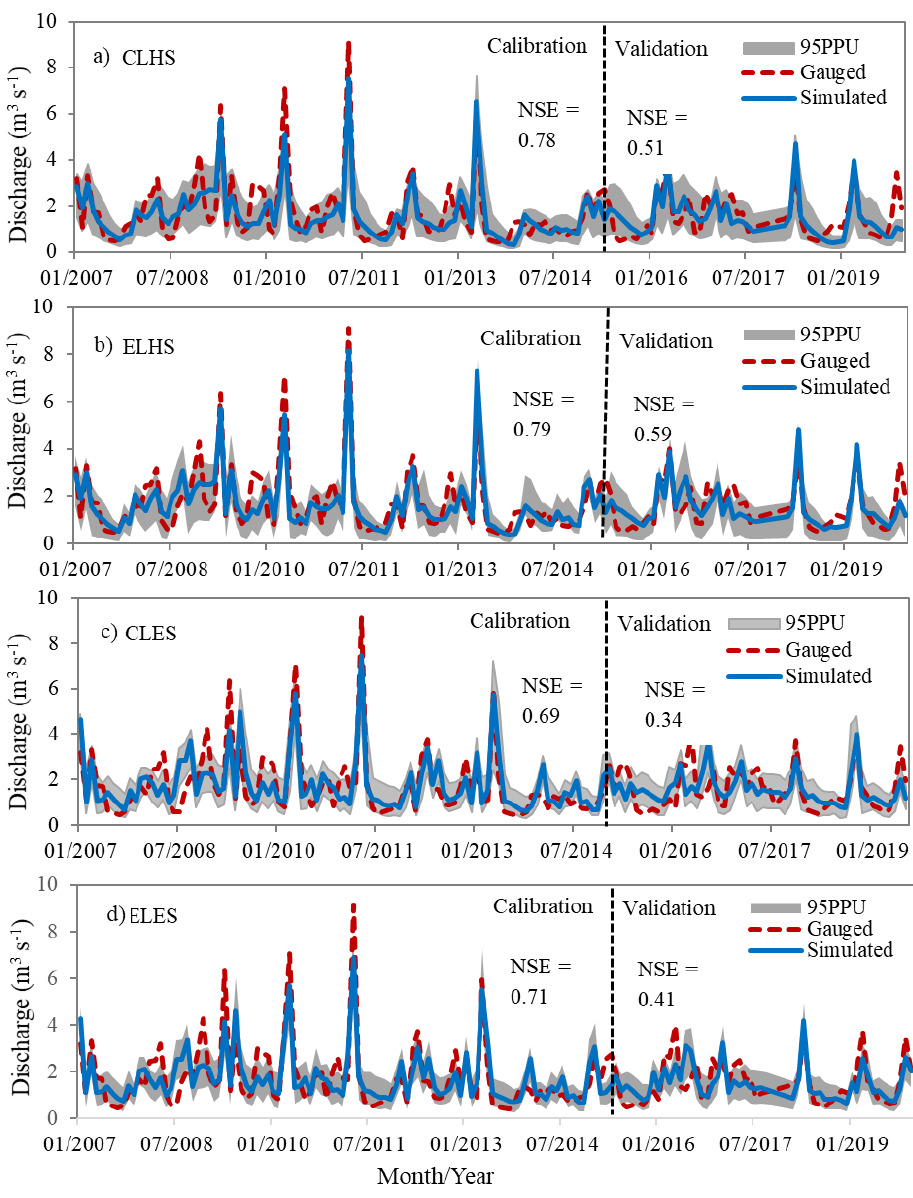
Figure 3. Comparison of gauged and simulated streamflow for the calibration period (2007–2014, left part) and the validation period (2015–2019, right part) for each of the four different models: ( a ) CLHS, ( b ) ELHS, ( c ) CLES, and ( d ) ELES, including the 95PPU band in